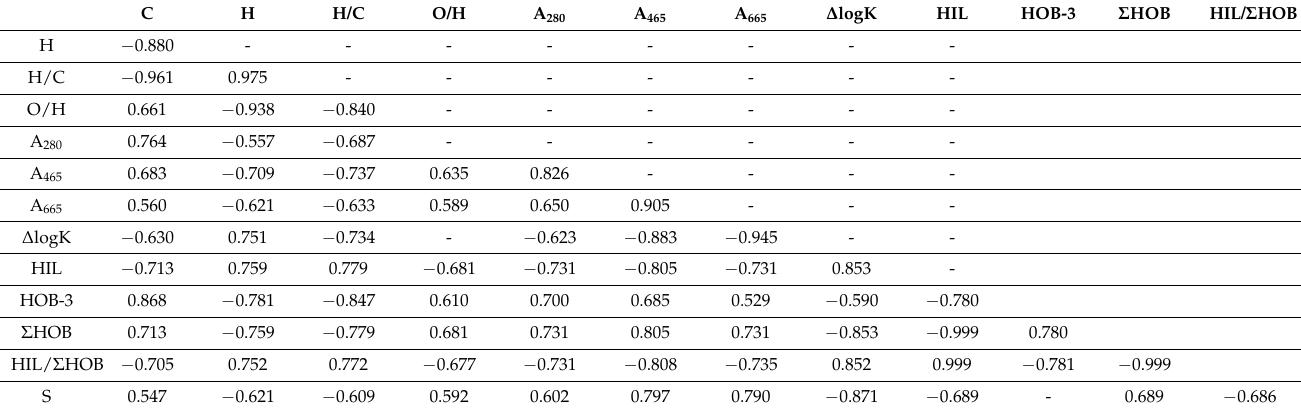
Table 9. Significant correlation coefficients ( p ≤ 0.05) between the parameters of humic